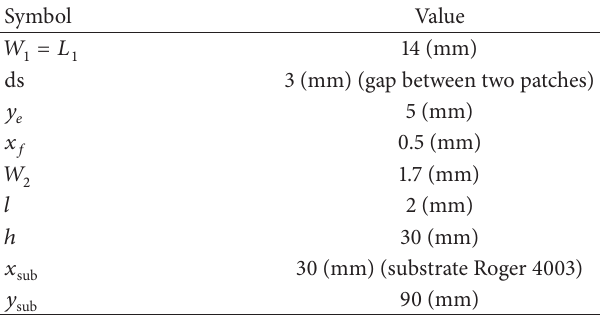
Table 3: Parameters of LHM beam steering antenna at 5.8 GHz as in Figure